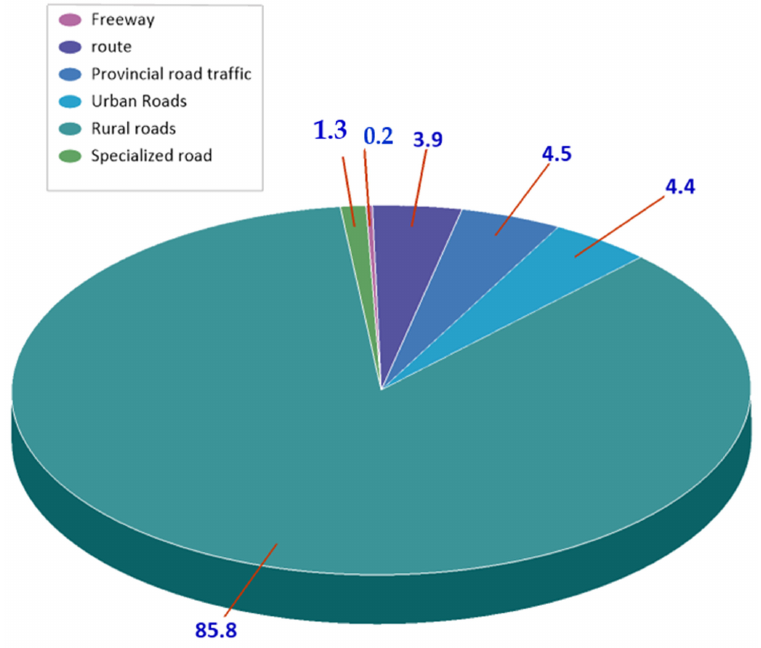
Figure 2. Proportion of road types in Vietnam (Vietnam Logistics Report